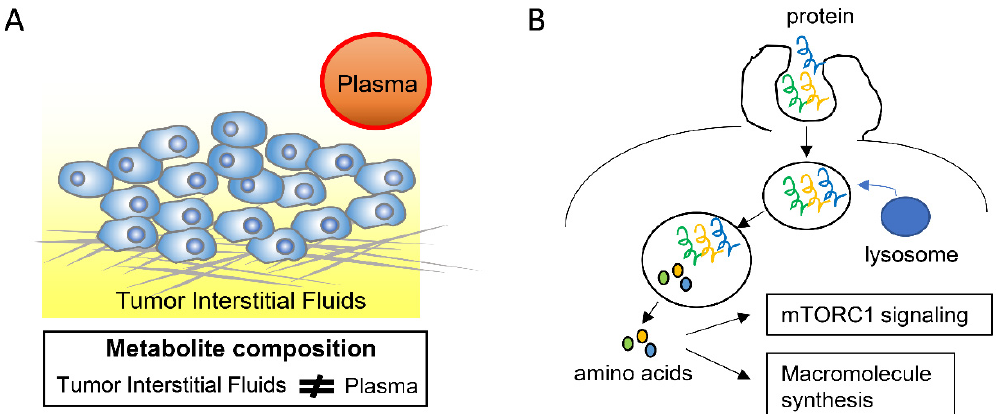
Figure 2. Adaptation to nutrient-altered tumor microenvironments. ( A ). Measuring the absolute concentrations of 120 metabolites with mass spectrometry identified that the metabolite composition of the tumor interstitial fluid in pancreas and lung tumors differs from that of the circulation plasma [38]. ( B ). Macropinocytosis of extracellular proteins serves a source of amino acids in pancreatic cancer cells, which could activate mechanistic target of rapamycin complex 1 (mTORC1) signaling and be used for macromolecule synthesis.